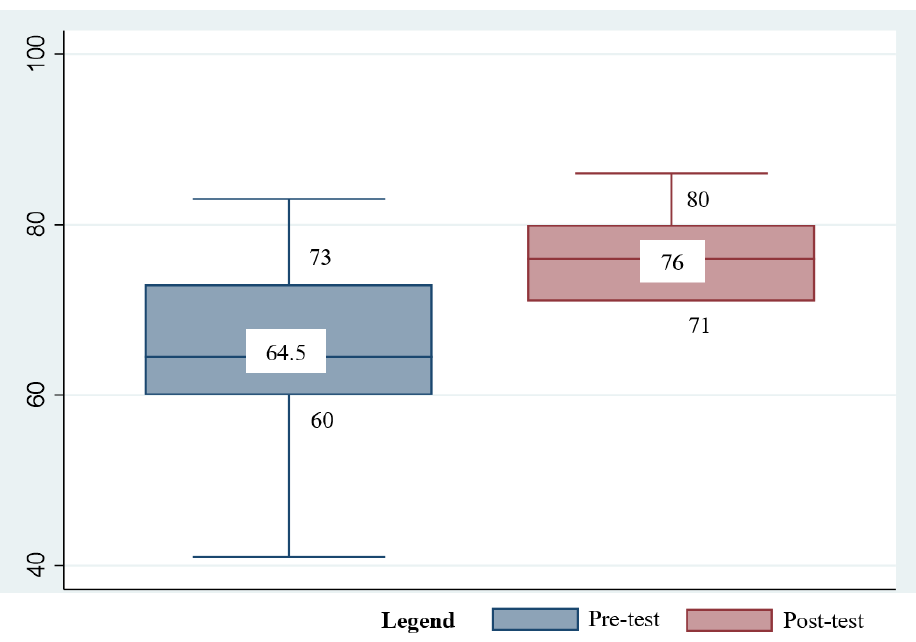
Figure 3. Box plot of resilience scores at the baseline and post-intervention.